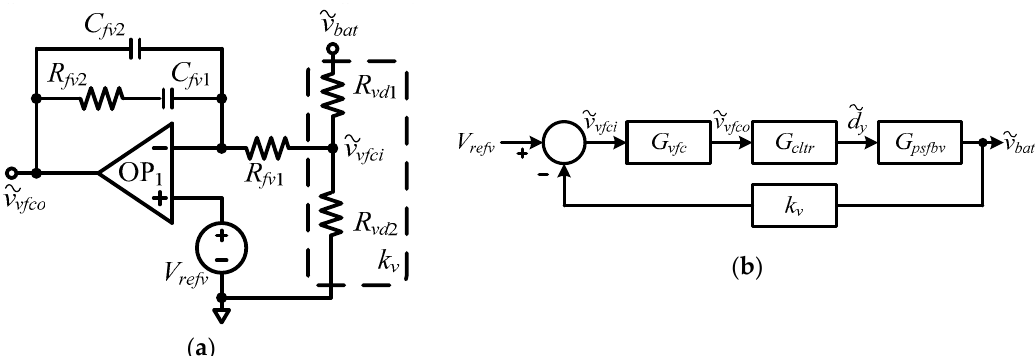
Figure 12. Charge voltage loop. ( a ) Voltage divider and voltage feedback controller (VFC) circuit. ( b ) Control block diagram of closed-loop operation. Figure 13. Bode plot simulations: G v ( s ), G comv ( s ), and G fbv ( s ).